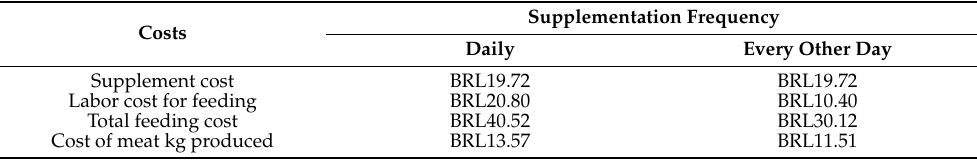
Table 8. Production costs of sheep submitted to intermittent supplementation on Masai grass pasture for 80